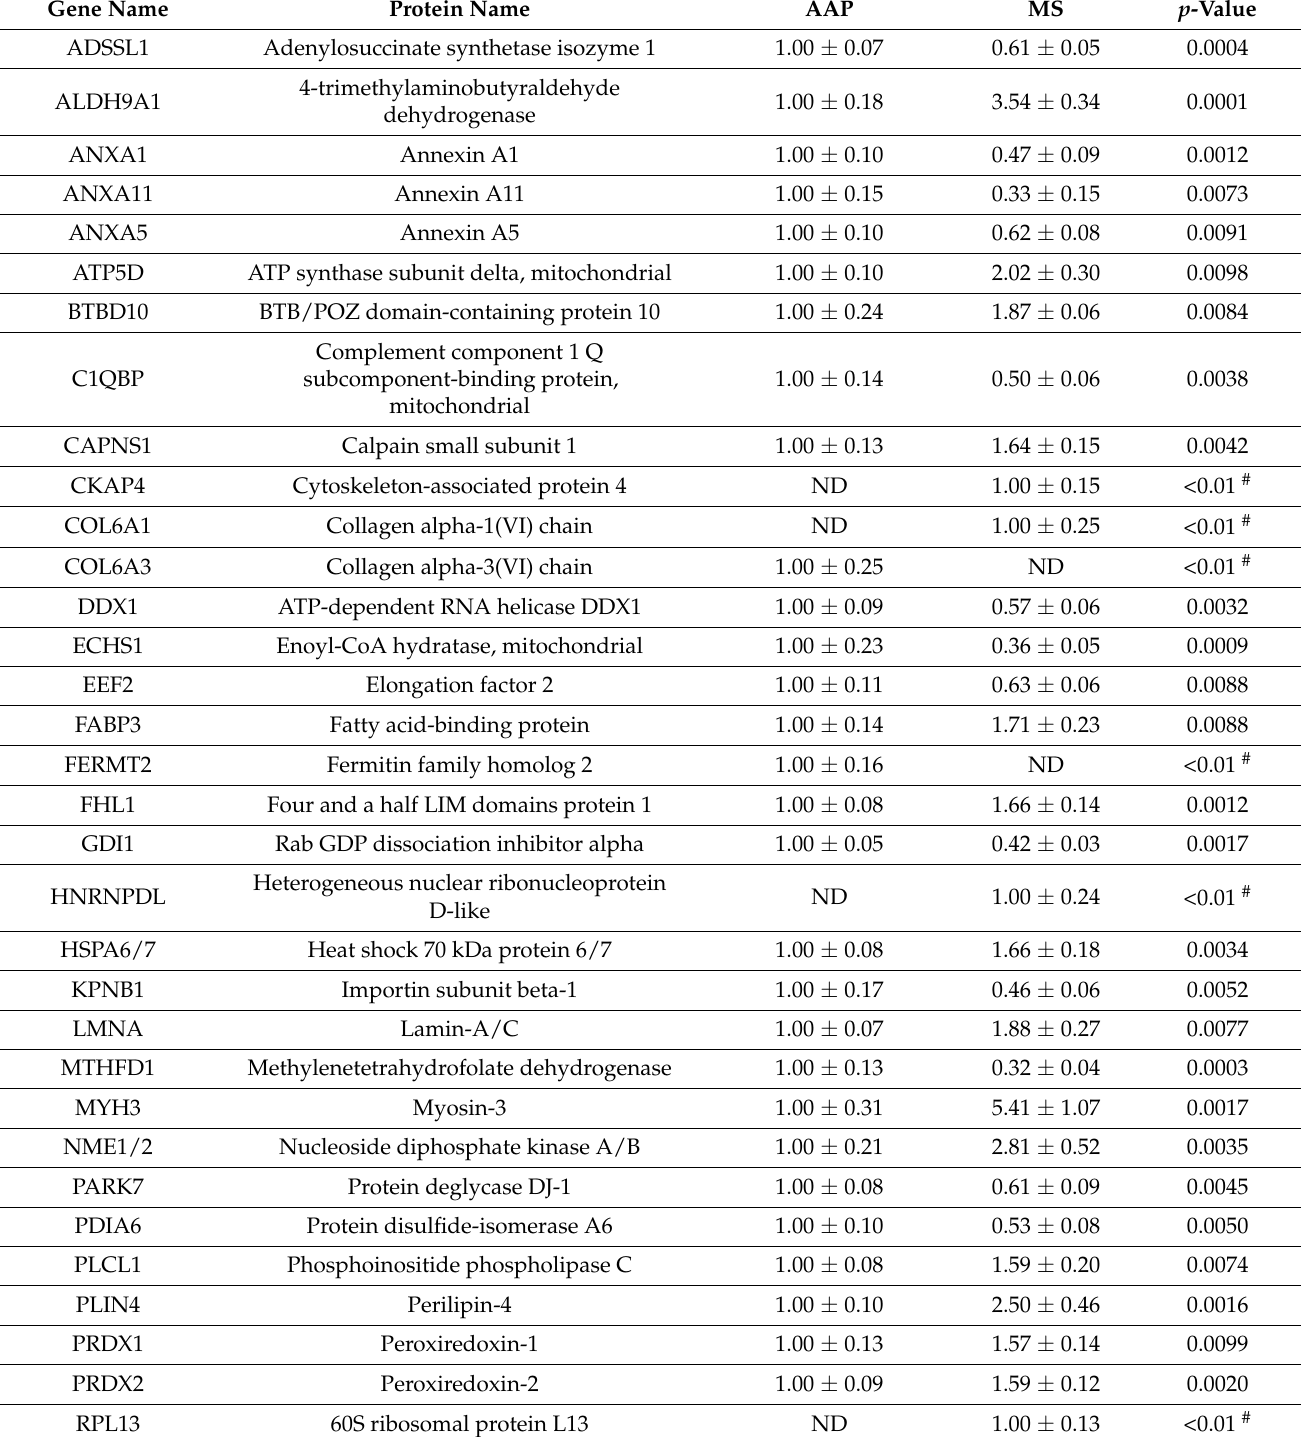
Table 2. The 40 proteins with significant differences between AAP and mood stabilizer groups. Data are given as fold changes (mean ± s.e.). Cutoff for significance was set at p < 0.01 or if a protein was not detected in one group but detected in one group and present in at least half of samples of the other group. The mean of the normalized PA for each protein in the AAP biopsy samples was set to 1.00, and the fold changes were relative to AAP. ND; not detected. # , only detected in a minimum of 4 out of the 8 AAP muscle samples or 4 out of the 8 MS muscle